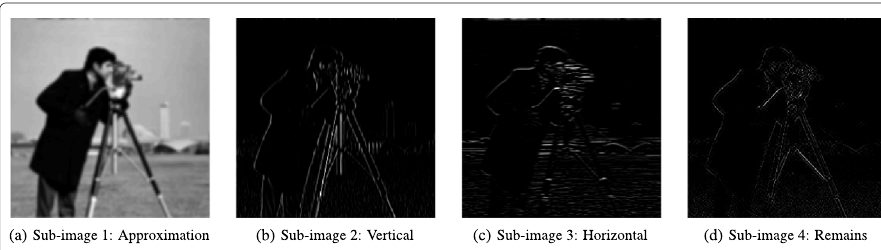
Fig. 12 Sub-images1–4 of the “Cameraman” image processed with the “ SSA-iSBD4-channelfilterbank ,” type “ vertical/horizontal ,” with L = 4